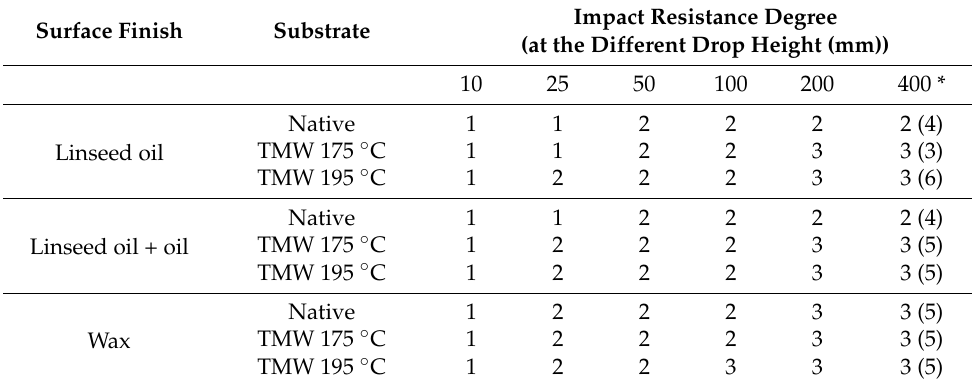
Table 9. Impact resistance of the surface finish: degree and evaluation.